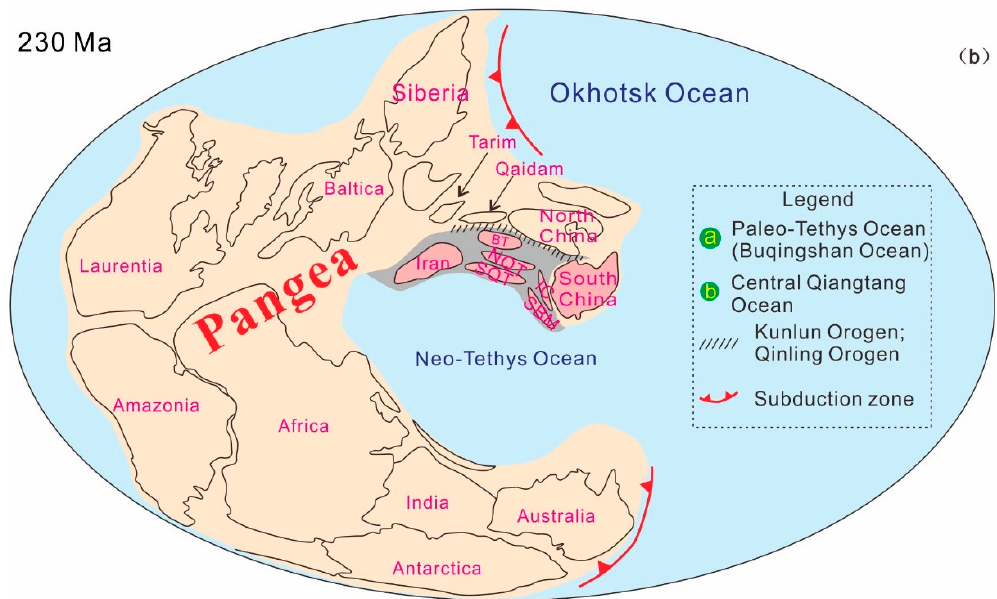
Figure 19. ( a , b ) Reconstruction of East Asian blocks showing the spreading and closure of Northern Paleo-Tethys Ocean (Buqingshan Ocean) (modified from the literature [32,52,157,163–165]). SQT— South Qiangtang Terrane; NQT—North Qiangtang Terrane; BT—Bayan Har terrane; SBM—Sibumasu Terrane; IC—Indochina Terrane.